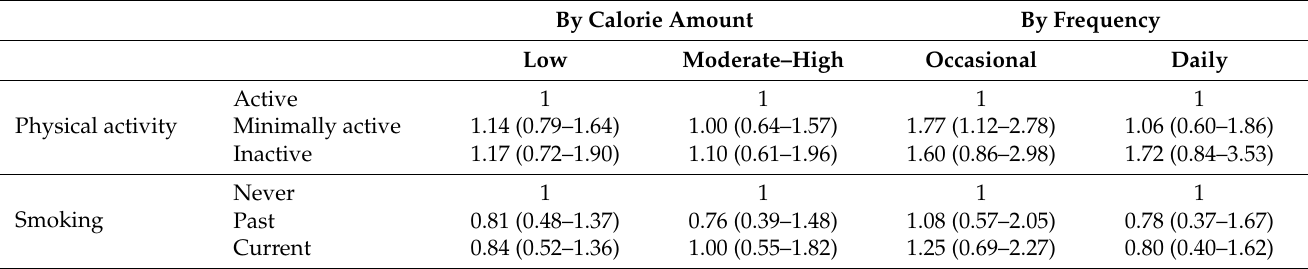
Table 6. Behavioral and social factors related to the different SSBs consumption patterns, adjusting each variable by age and sex using a multinomial regression